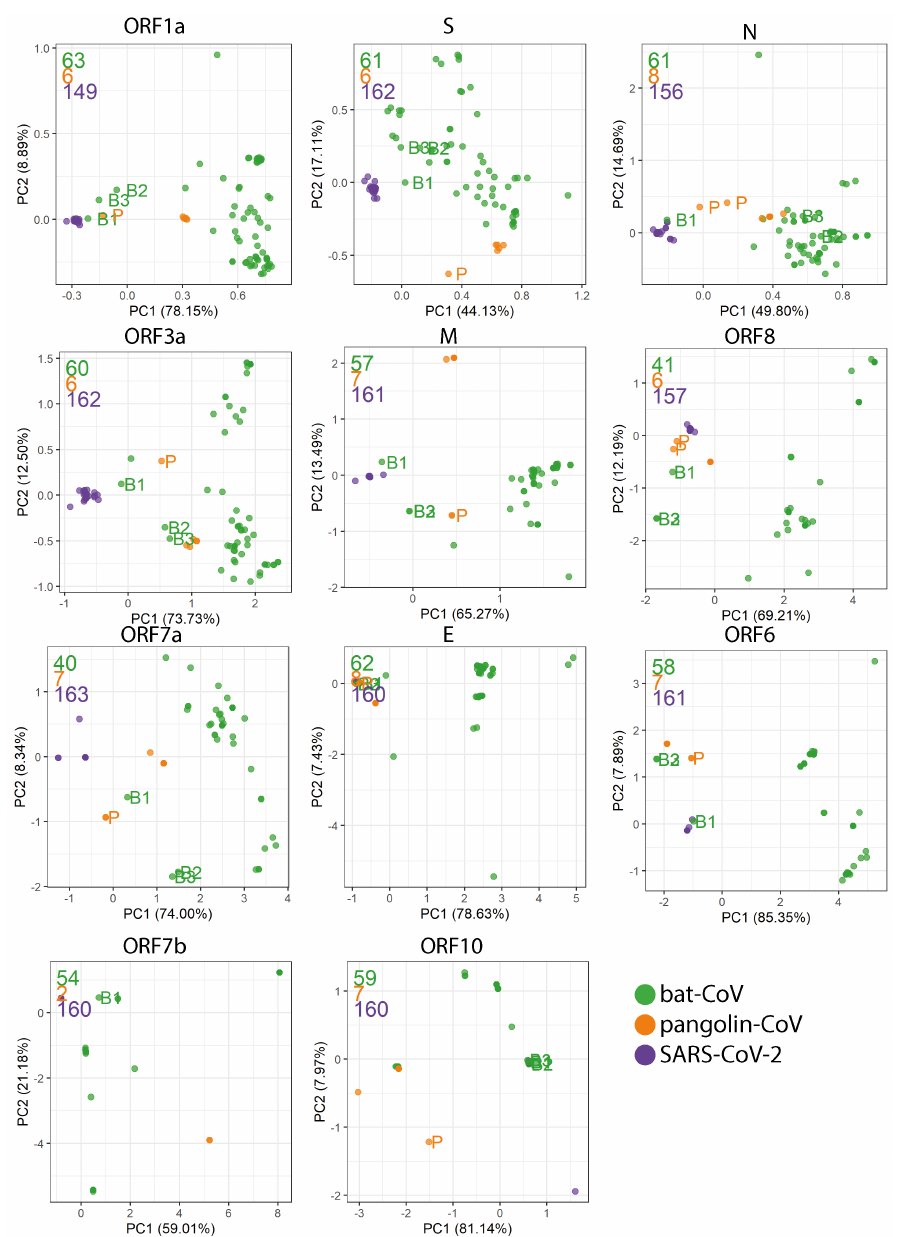
Figure 3. Relative synonymous codon usage (RSCU) was calculated as the ratio of the observed frequency of codon to the expected frequency under the assumption of equal usage between synony- mous codons for the same amino acids. For each gene, Principal Component Analysis (PCA) was carried out on the RSCU values. The first two Principal Components (PCs) are plotted. The total number of genomes used in each plot are indicated in the top left corner in the corresponding colour. In order, they are bat-CoV (green), pangolin-CoV (orange) and SARS-CoV-2 (purple). Four isolates are labelled: bat-RaTG13 (B1), bat-SL-CoVZC45 (B2), bat-SL-CoVZXC21 (B3) and pangolin-MP789 (P; MT121216.1 and